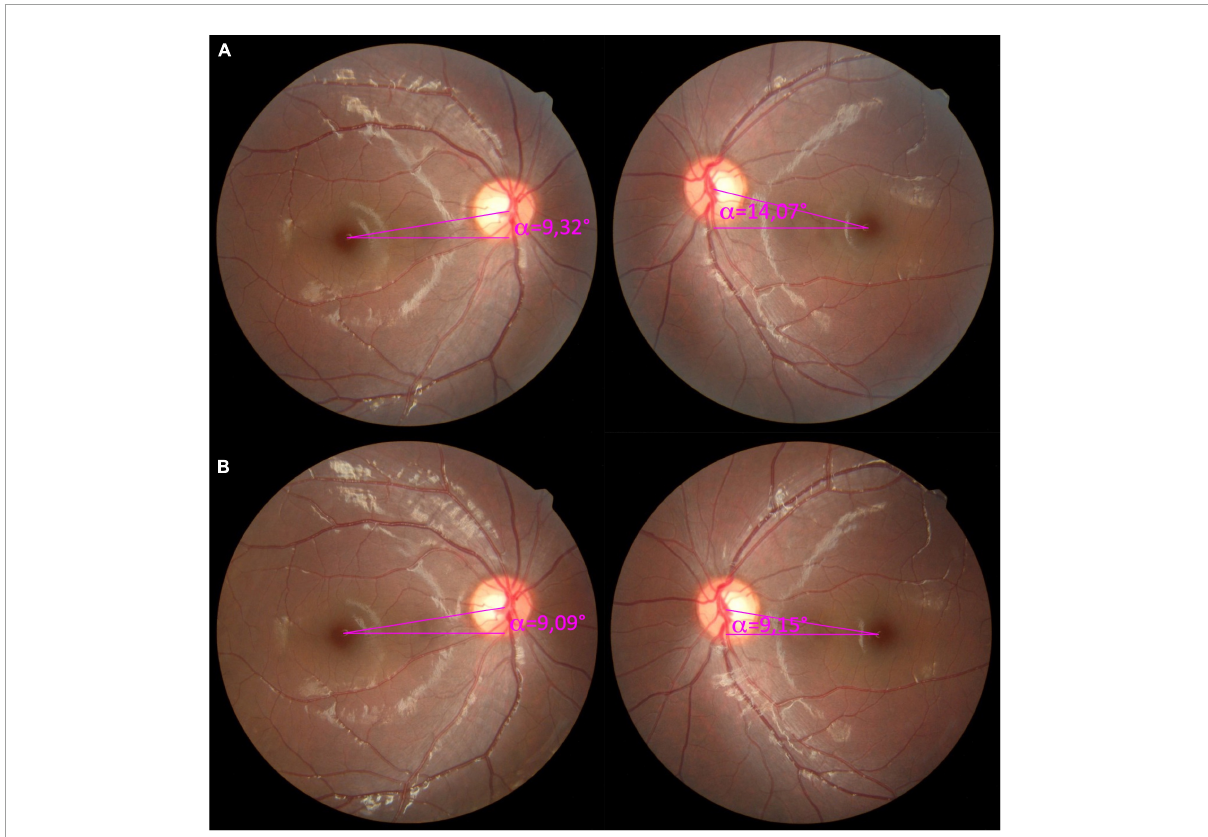
FIGURE2 Pre- and postoperative color fundus photographs for Patient 15. (A) The preoperative color fundus revealed a disc-fovea angle (DFA) of 9.32 ◦ in the right eye and 14.07 ◦ in the left eye, with 5 ◦ of excyclotorsion in the left eye measured with the double Maddox rod (DMR) test. (B) At the postoperative 3-month follow-up, the DFA was 9.09 ◦ in the right eye and 9.15 ◦ in the left eye with no subjective torsion at the DMR